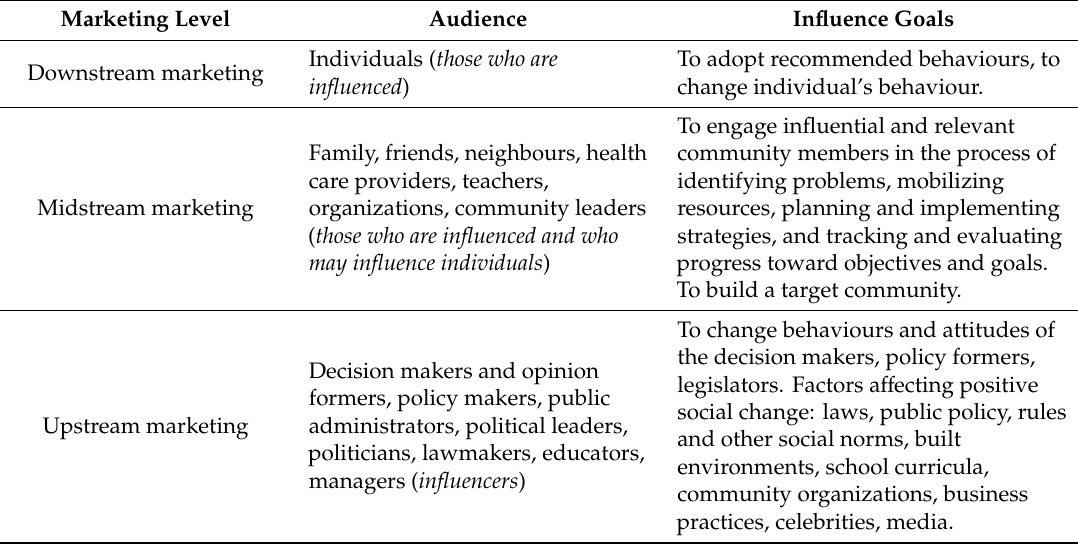
Table 3. Definitions of social marketing levels, audiences and